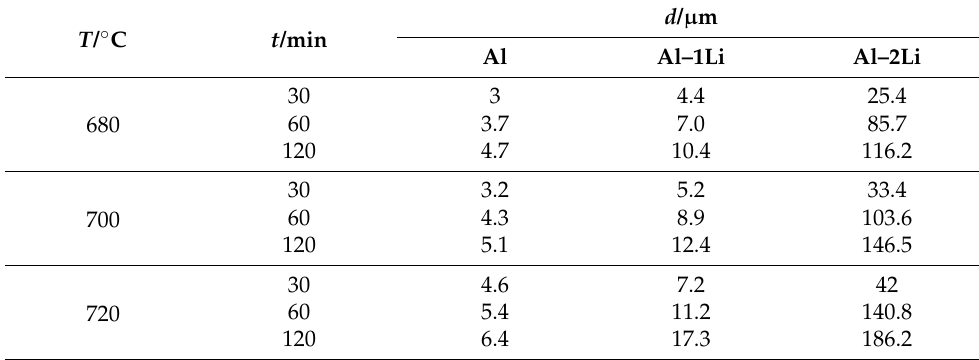
Table 3. Measurements of thickness of DRL.